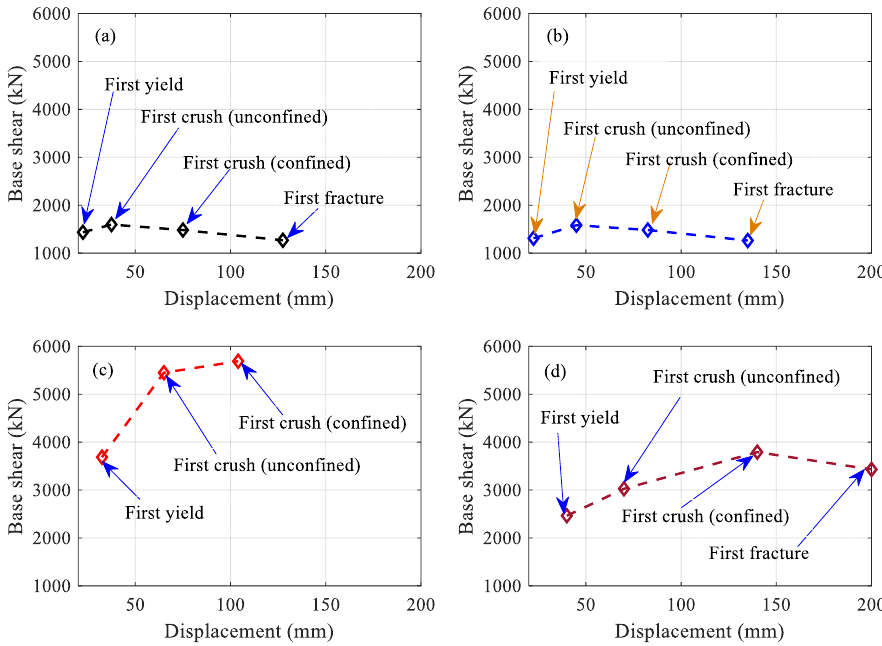
Figure 11. Damage pattern obtained for various damage scenarios: ( a ) open ground story RC-SIM infilled frame with lintel beam; ( b ) open ground story RC-URM infilled frame with lintel beam; ( c ) full RC-SIM infilled frame with lintel beam; and ( d ) full RC-URM infilled frame with lintel